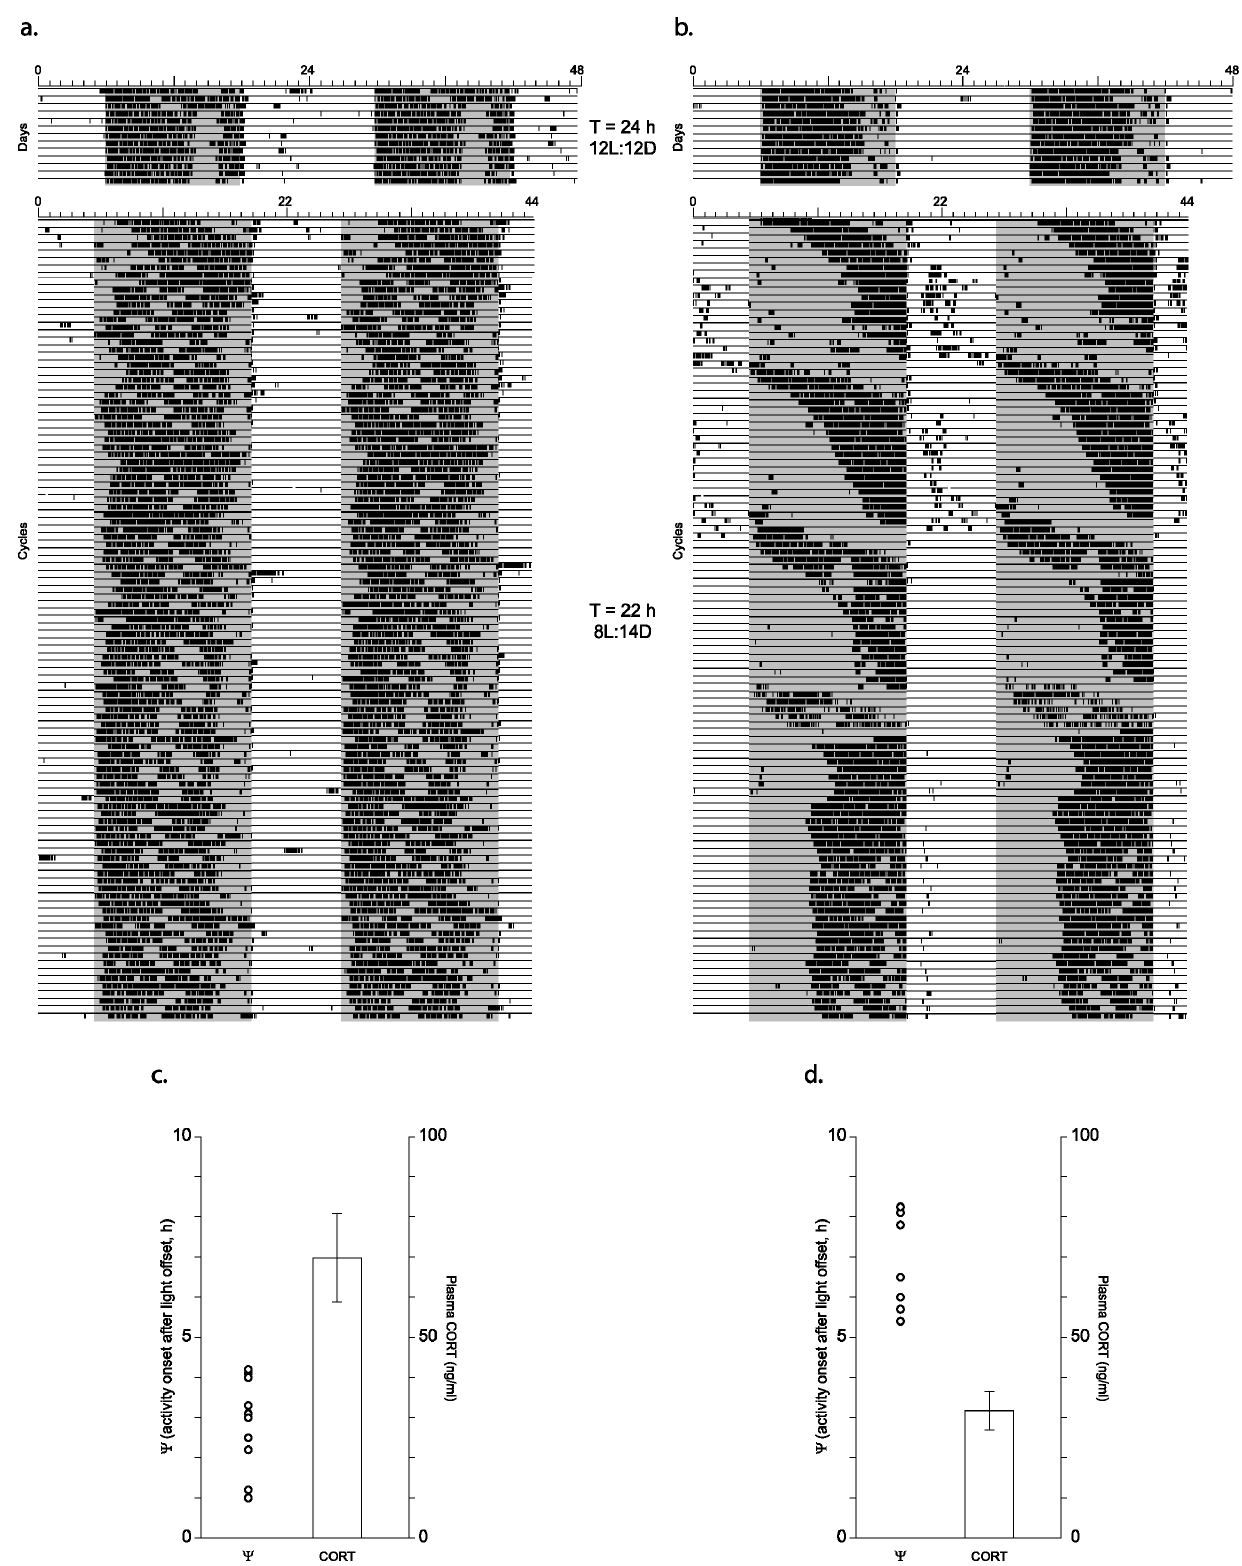
Figure 7. Wheel-running activity records and peak plasma CORT values of wild type mice in 8L:14D. (a) An animal that re-entrained to 8L:14D quickly with activity onsets , 1 hour delayed after light offset. (b) An example of an animal that required < 2 months to re-entrain to 8L:14D with activity onsets delayed . 5 h after light offset. (c) Peak plasma CORT values of mice with Y s # 4.2 h delayed (n=12) as illustrated by example in panel (a). (d) Peak plasma CORT values of mice with Y s $ 5.4 h delayed (n=7) as illustrated by the example in panel (b). CORT values of animals with a Y $ 5.4 h delayed were significantly less than CORT values of animals with a Y # 4.2 h delayed (p , 0.03). doi:10.1371/journal.pone.0111944.g007 PLOS ONE |